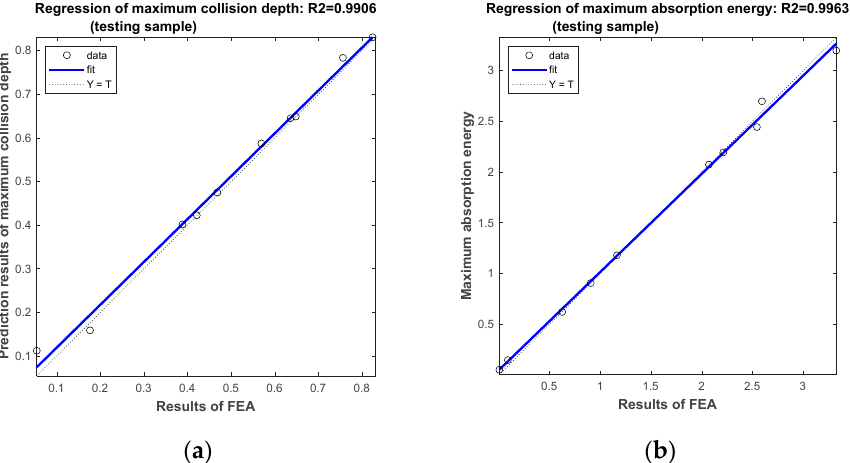
Figure 6. Regression for testing samples. ( a ) Regression of maximum collision depth, ( b ) regression of maximum absorption energy.